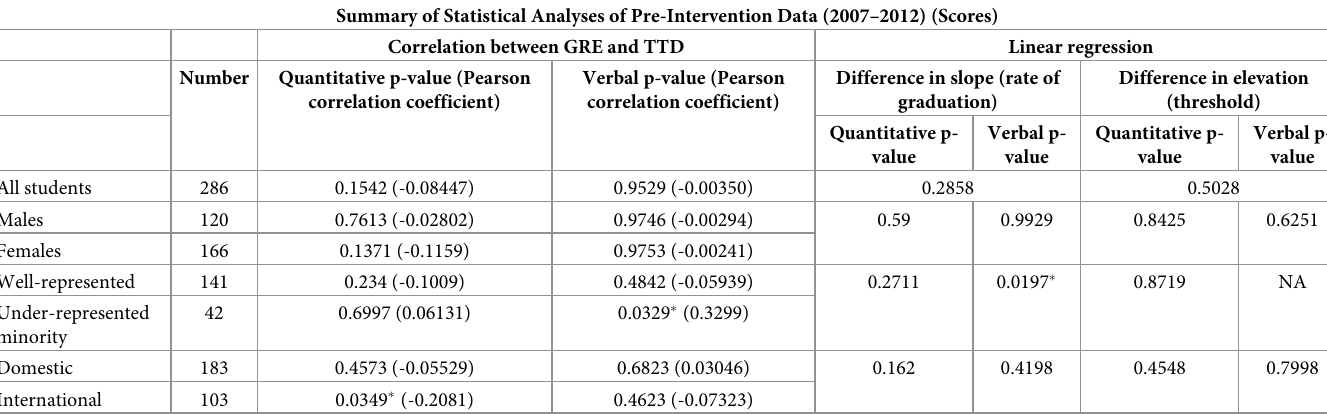
Table 4 outlines the statistical analyses that were conducted on the data regarding GRE scores and time to degree. Statistically significant correlations were observed for international student Quantitative GRE scores and TTD with a p-value of 0.0349, and URM student Verbal GRE scores and TTD with a p-value of 0.0329. Data analyzed showed a statistically significant difference in slope (rate of graduation) based on representation with a p-value of 0.0197.